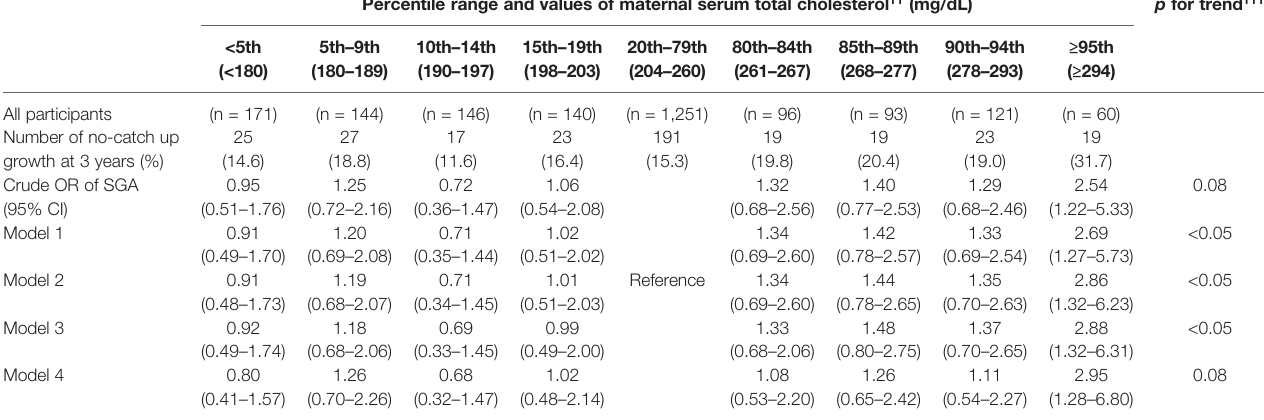
† at term according to percentile ranges of maternal serum total